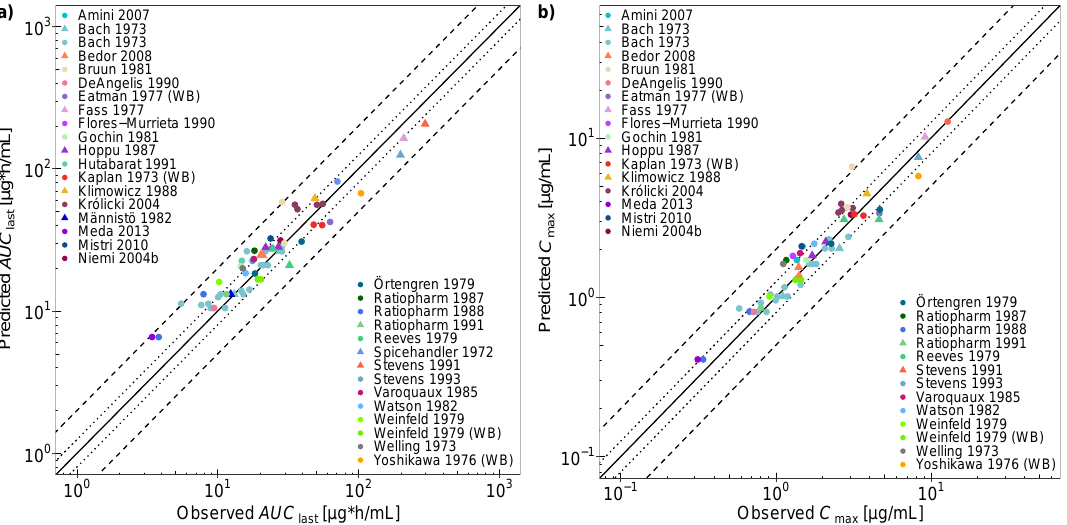
Figure 4. Trimethoprim PBPK model performance. The goodness-of-fit plots show predicted compared to observed ( a ) AUC last values and ( b ) C max values of all studies used for model building and evaluation. Thesolidlinemarksthelineofidentityanddottedlinesindicate1.25-foldanddashedlinesindicate2-fold deviation. Dataareshownastriangles(trainingdataset)ordots(testdataset)[30,31,33,37,41,43,46,51–73]. Details on the predicted clinical studies and the individual AUC last and C max values are provided in the Supplementary Materials. WB, whole